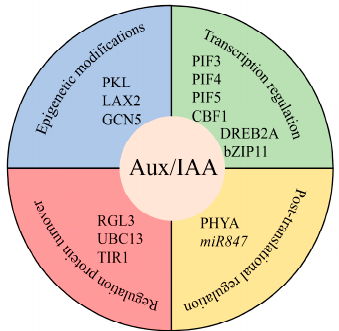
Figure 3. Aux/IAA proteins might be regulated at different levels. PKL, PICKLE; LAX2, LIKE AUXIN RESISTANT 2; GCN5, general control nonderepressible 5; PIF3, PHYTOCHROME INTERACTING FACTOR 3; PIF4, PHYTOCHROME INTERACTING FACTOR 4; PIF5, PHYTOCHROME INTERACTING FACTOR 5; CBF1, C-repeat binding factor 1; DREB2A, dehydration-responsive element binding protein 2A; bZIP11, basic leucine zipper 11; PHYA, PHYTOCHROME A; RGL3, RGA-LIKE3; UBC13, UBIQUITIN-CONJUGATING ENZYME 13; TIR1, TRA NSPORT INHIBITOR RESPONSE 1/AUXIN SIGNALING F-BOX.